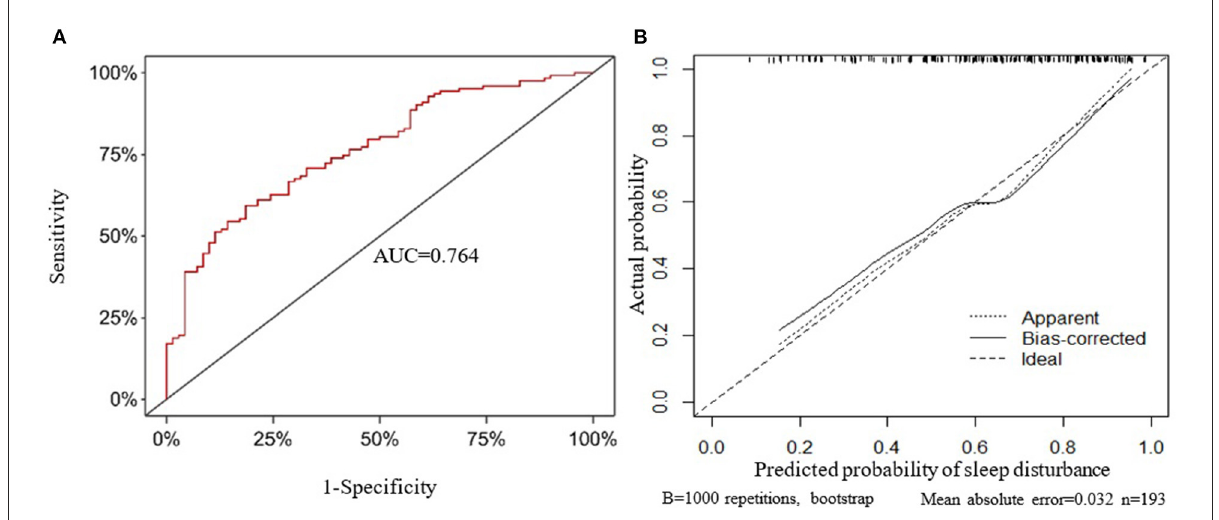
FIGURE3 Internal validation of the prediction model. (A) The receiver operating characteristic curve. (B) Calibration curve. AUC, area under the